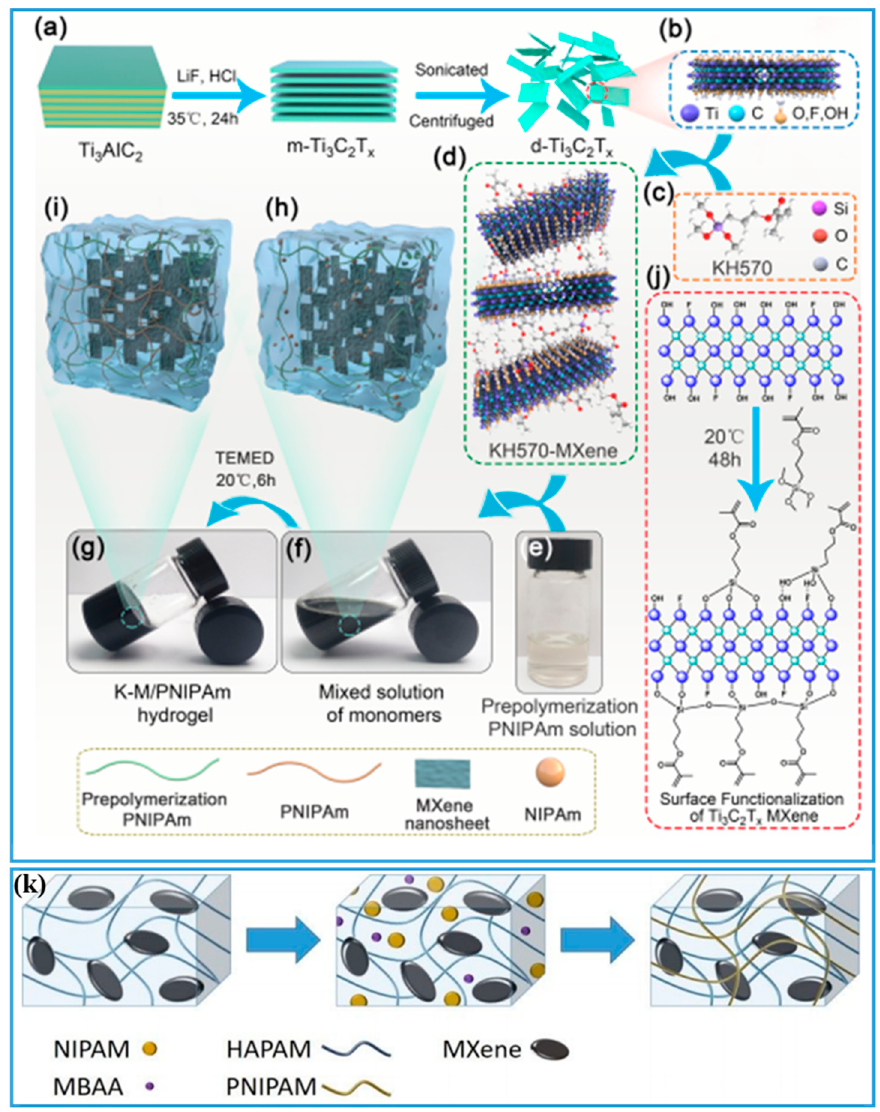
Figure 6. ( a ) Illustration of preparation process of Ti 3 C 2 T x Mxene. ( b ) Structure of Ti 3 C 2 T x Mxene. ( c ) Structure of KH570. ( d ) Structure of KH570-Mxene. ( e ) Picture of PNIPAM-PAM solution. ( f ) Picture of mixed solution with MXene. ( g ) Picture of prepared PNIPAM-ECH. ( h ) Structure of mixed solution with MXene. ( i ) Structure of prepared PNIPAM-ECH. ( j ) Illustration of surface functionalization of MXene. Copyright from Ref. [121] ACS publications. ( k ) Illustration of preparation of double network PNIPAM-ECH. Copyright from Ref. [120] ACS publications.